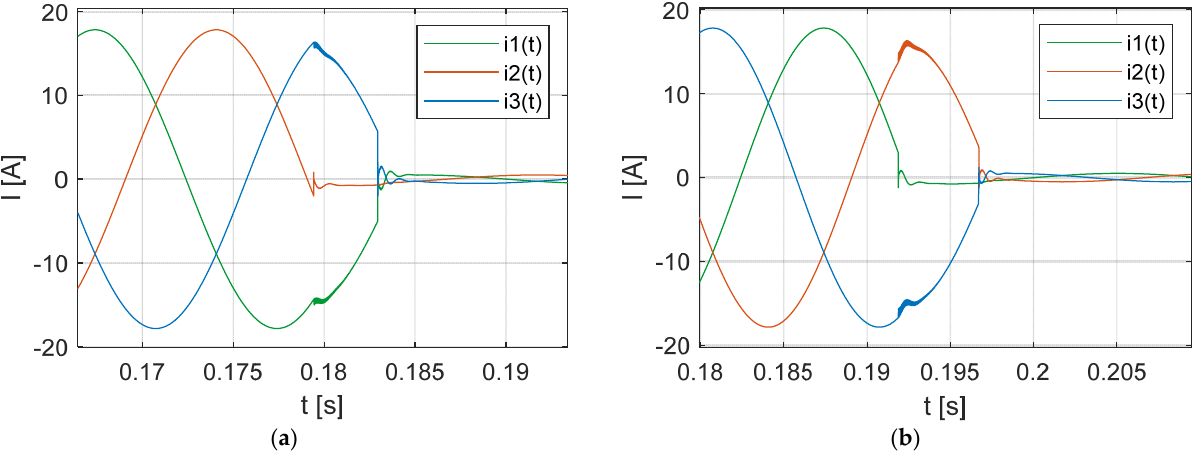
Figure 7. Simulation results (EMTP algorithm) ( a ) VCB; ( b ) Oil CB. Source: own calculations.